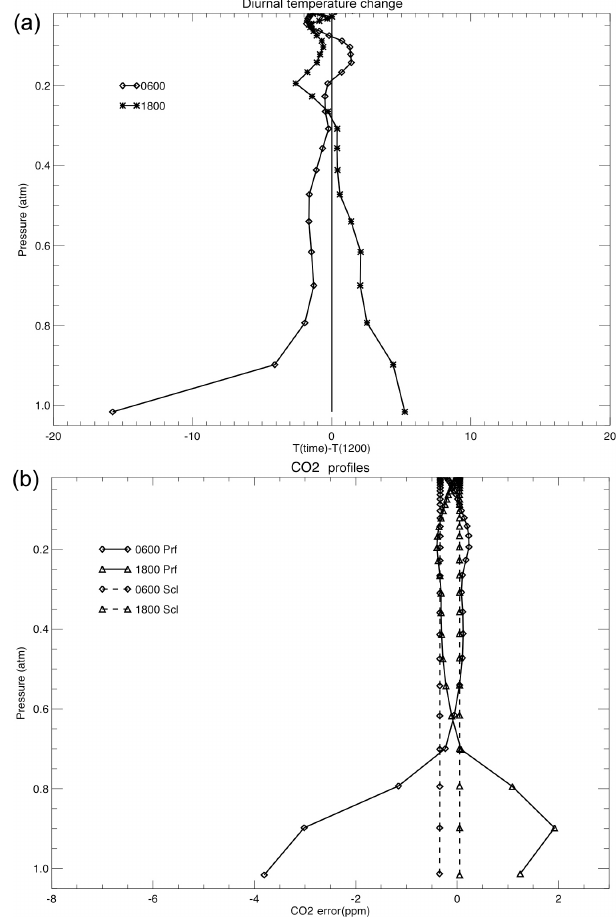
Figure 8. (a) NCEP temperature profiles at 06:00 and 18:00 for a single day, less the profile at 12:00 on the same day. (b) Error in CO 2 retrievals produced by not accounting for the temperature changes of (a) . Dashed lines for profile scaling, solid for profile